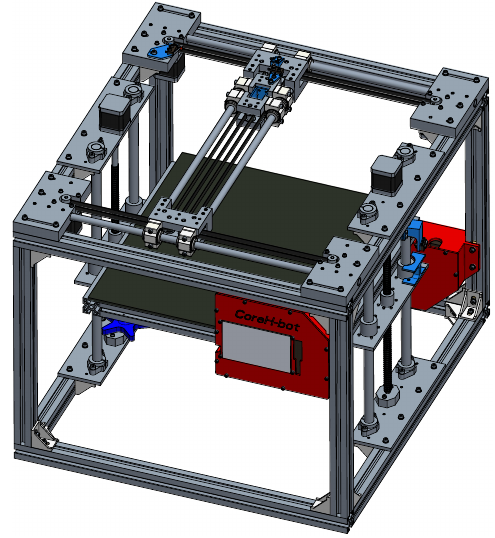
Figure 11. Top view (with the belt